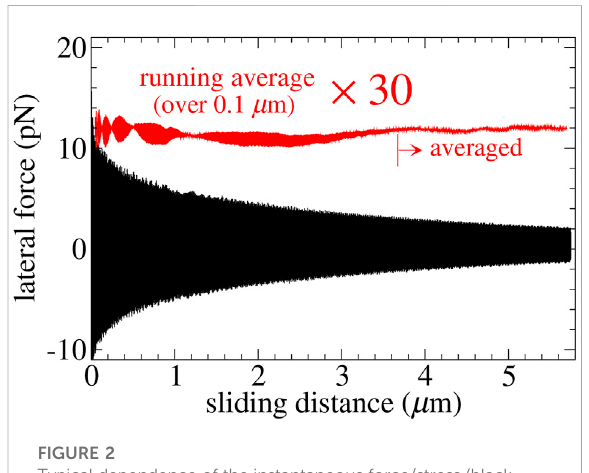
FIGURE 2 Typical dependence of the instantaneous force/stress (black lines) on slid distance for the y -stripe at a sliding velocity of v ⊥ = 50 m/s. Averages were only taken over the last 2 μ